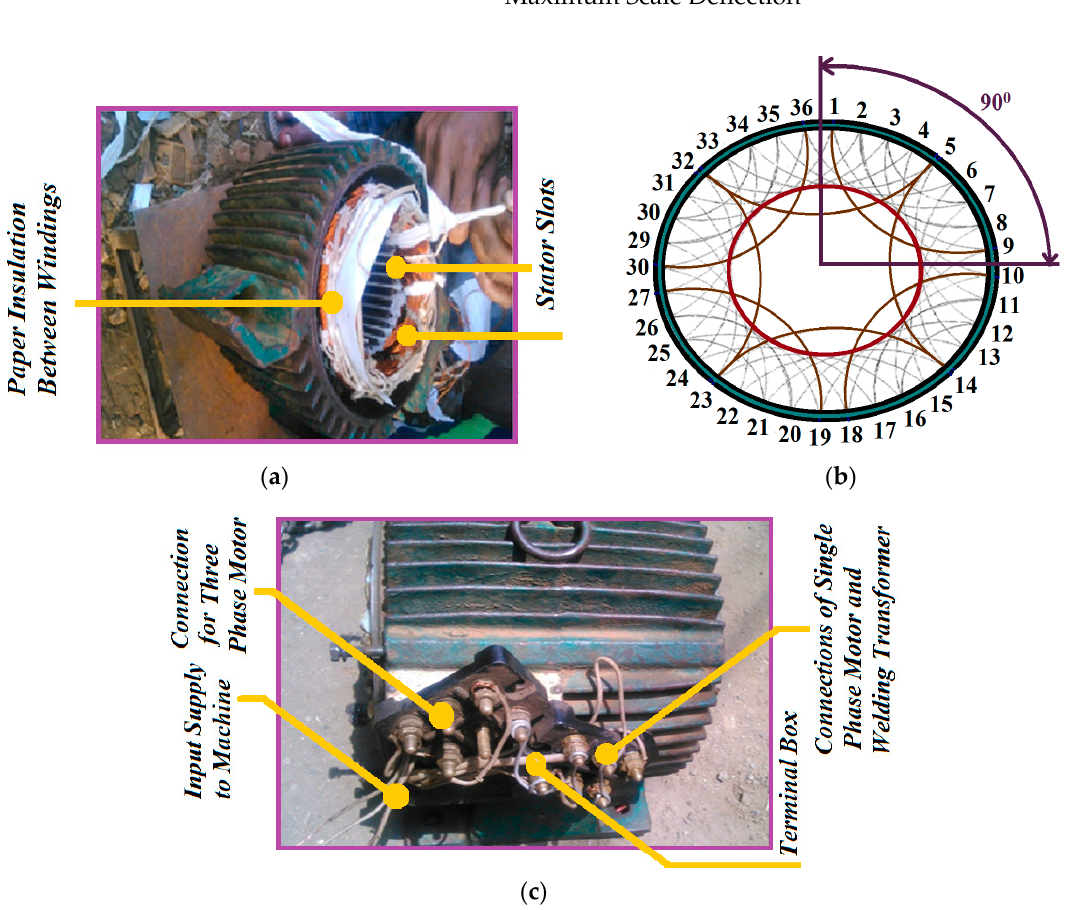
Figure 7. Design of the proposed induction machine: ( a ) hardware implementation of the stator winding; ( b ) complete stator winding arrangement; ( c ) proposed induction machine end terminal connection.